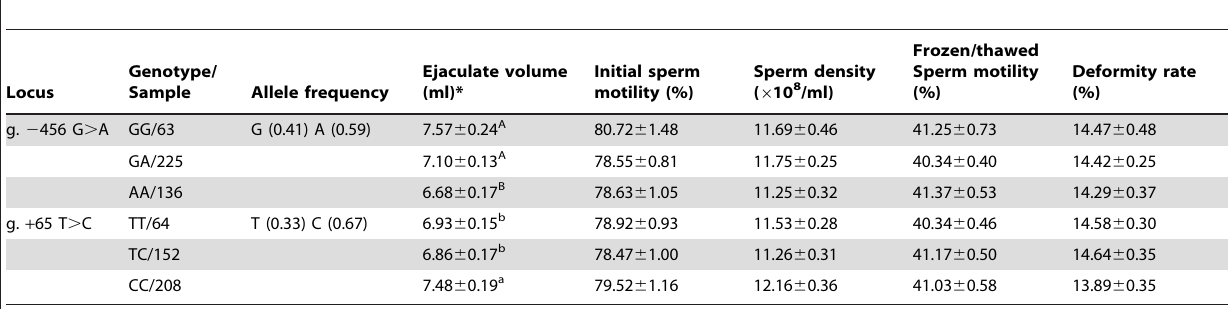
Table 3. Least square means (LSM) and standard error (SE) for semen quality traits of different genotypes in bovine PLCz gene of Chinese Holstein bulls.